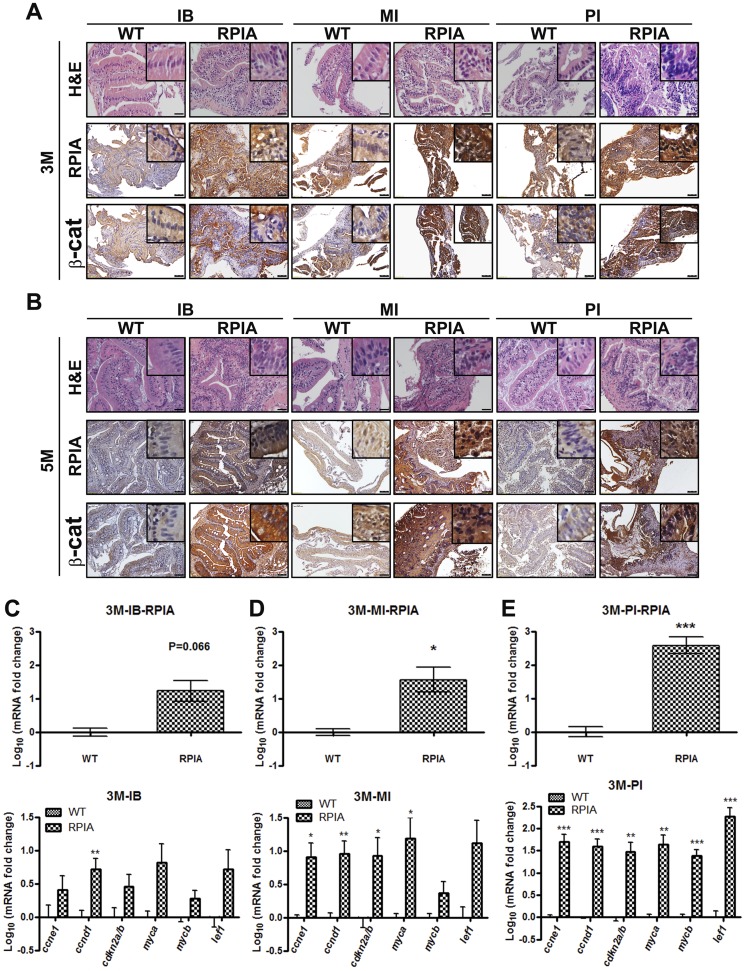
RPIA promotes β-catenin expression and tumorigenesis in vivo.(A and B) In the upper panels, the HE stain was examined in the AB line (WT) and in (A) 3M and (B) 5M Tg (ifabp:RPIA) zebrafish. As shown in the bottom panels, via IHC, β-catenin expression levels were increased in (A) 3M and (B) 5M Tg (ifabp:RPIA) fish as well as in different regions of the intestine: IB, MI, and PI. Magnification: 400X for HE and 200X for IHC. Scale bar: 20 μm for HE and 50 μm for IHC. (C-E) β-catenin target genes were elevated in 3M Tg (ifabp:RPIA) fish, especially in (E) the PI. The expression level of β-catenin target genes was analyzed in 3M control fish (n = 6) and RPIA Tg fish (n = 18) from three portions of guts. The gene expression levels were analyzed with qPCR. There are extreme data in each group, so they are removed for the statistical analysis. (C) For IB, the number of WT is 6, and the number for RPIA is 7. (D) For the MI, the number of WT is 6, and the number for RPIA is 13. (E) For PI, the number of WT is 3, and the number for RPIA is 9. The statistical significance was calculated with Student t test (* 0.01 < P < 0.05). Data can be found in S5 Data. 3M, 3-month-old; 5M, 5-month-old; ccne1, cyclin E1; ccnd1, cyclin D1; cdkn2a/b, cyclin-dependent kinase inhibitor 2a/b; HE, hematoxylin and eosin; IB, intestinal bulb; IHC, immunohistochemistry; lef1, lymphoid enhancer factor 1; MI, middle intestine; myca, oncogenes c-myca; mycb, oncogenes c-mycb; PI, posterior intestine; qPCR; quantitative PCR; RPIA, ribose-5-phosphate isomerase A; Tg, transgenic; WT, wild-type.